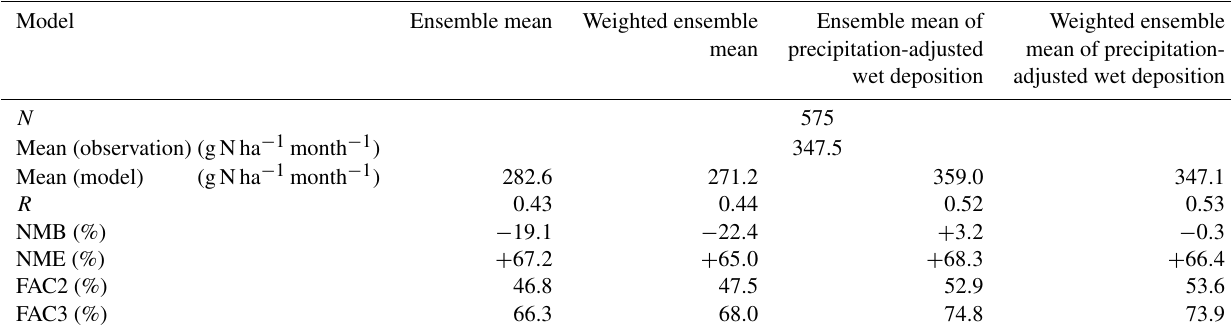
Table 7. Summary of the statistical analysis of model performance by ensemble and precipitation-adjusted approaches for the wet deposition of N.